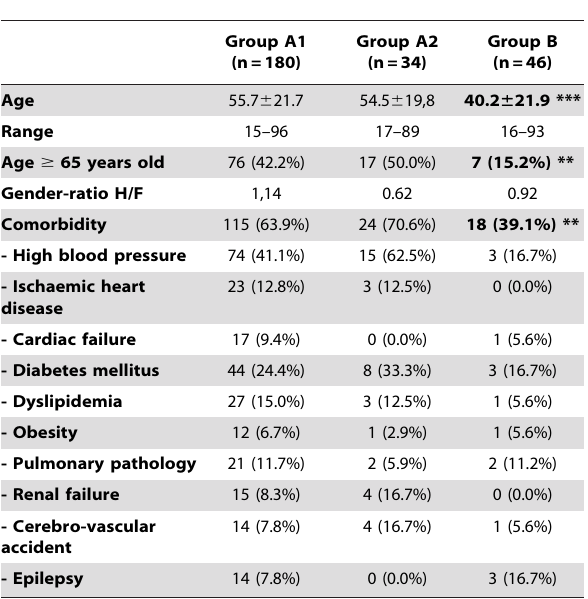
Figure 1. Patients entering the emergency department and displaying the clinical signs associated with Chikungunya. doi:10.1371/journal.pone.0007603.g001 Table 1. Demographic